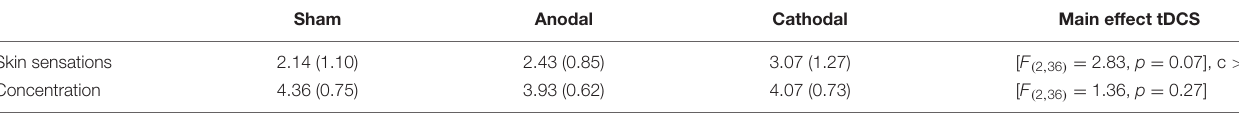
TABLE 2 | Skin sensations and perceived concentration during tDCS sessions (mean and standard deviation).